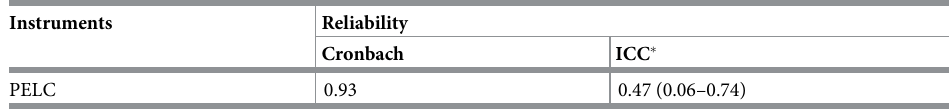
Table 3. Reliability for the PELC instrument (n = 124).